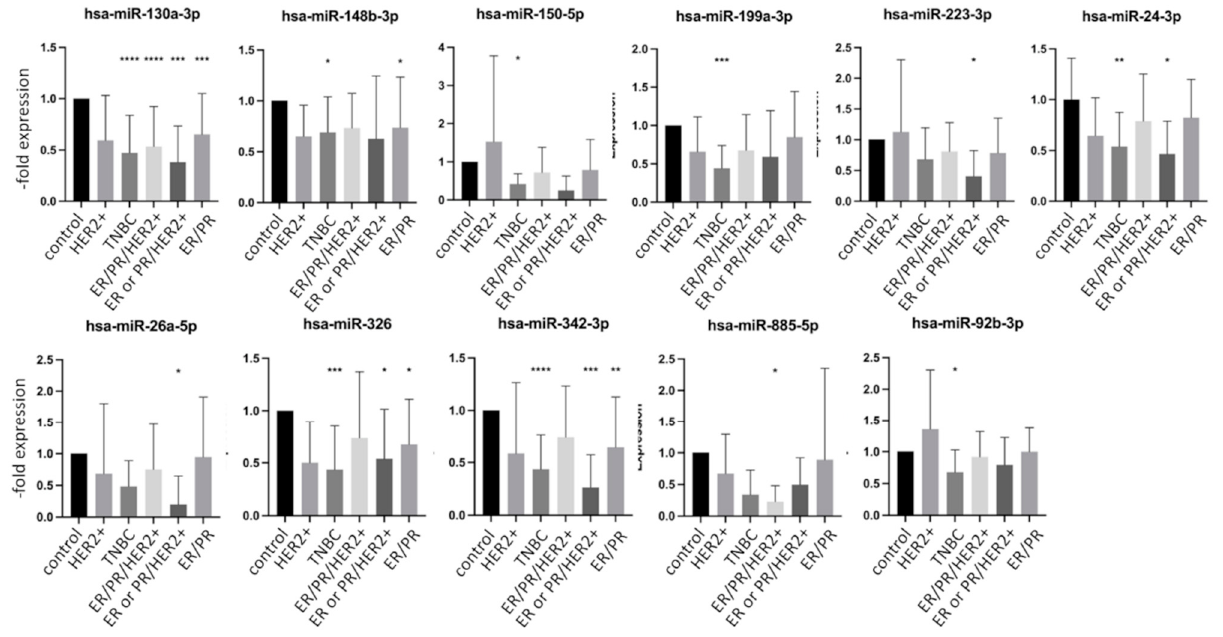
Figure 5. Expression levels of downregulated miRNA in exosomes from healthy controls and breast cancer patients with or without metastases divided by tumor markers. Data are presented as mean values of fold expression over the control group with standard deviations, * p < 0.05, ** p < 0.01, *** p < 0.001, **** p < 0.0001.